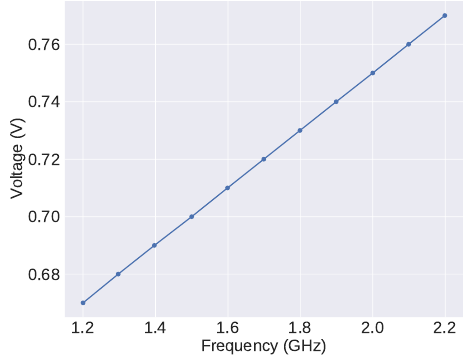
Figure 3. Frequency voltage